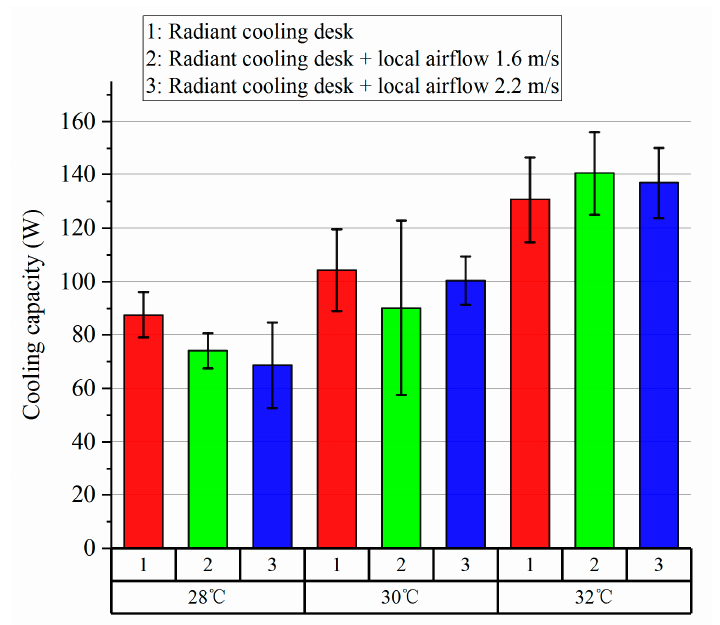
Figure 9. Cooling capacity of radiant cooling desk under different conditions.